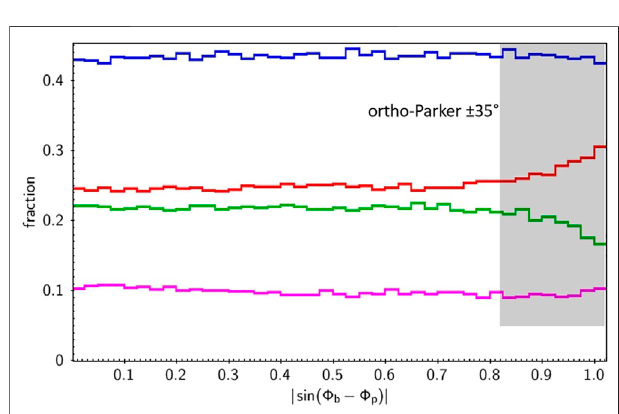
FIGURE 3 | Fractions of the different solar wind populations (SRR in red, SBOinblue,CHOingreen,andejectainmagenta)asafunctionof|sin( Φ B − Φ P )|. Parker orientations are to theleft and ortho-Parker orientations ± 35 ° areidenti fi ed by the grey box to the